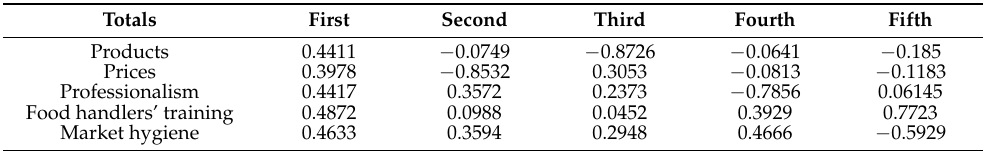
Table 5. Coefficients of the principal components (PC).